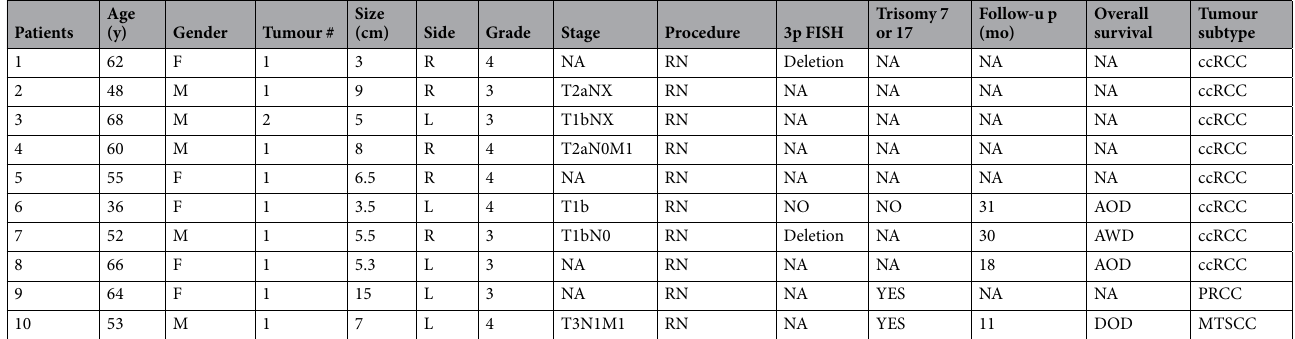
Table 1. Clinicopathological features of RCC with ECIs. Abbreviations: F, female; M, male; L, left; R, right; NA, not available; RN, radical nephrectomy; ccRCC, clear cell renal cell carcinoma; PRCC, papillary renal cell carcinoma; MTSCC, mucinous tubular and spindle cell carcinoma; DOD, dead of disease; AOD, alive without disease; AWD, alive with